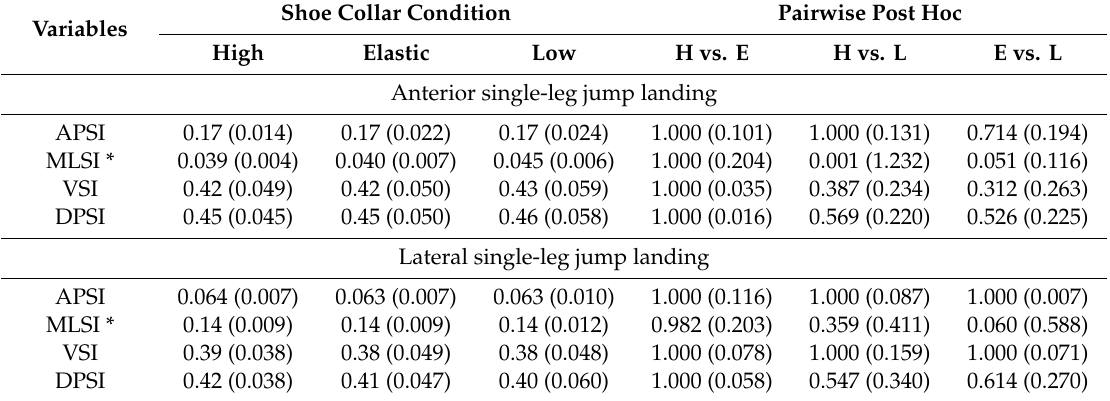
Table 2. Mean (standard deviation) of dynamic postural stability index and pairwise post hoc p -value (Cohen’s dz) during tasks in the high-, elastic-, and low collar shoe conditions. Shoe Collar Variables